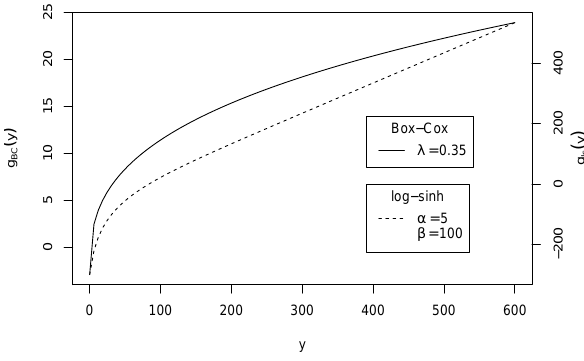
Fig. 1. Behavior of the Box-Cox (solid line) and log-sinh (dashed line) transformation as a function of the output variable (e.g. discharge in l/s) with parameters used in this study.